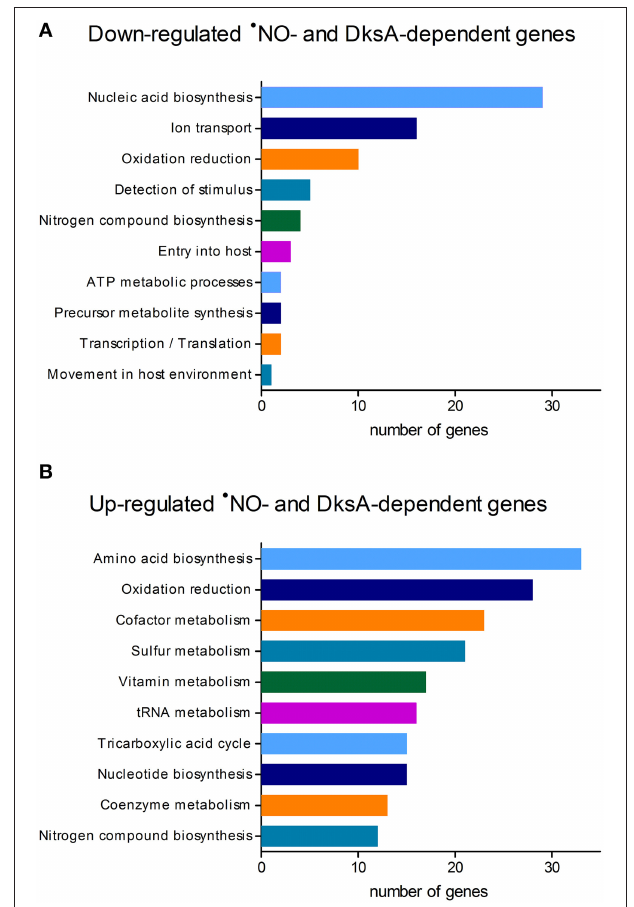
FIGURE 1 | Functional annotation of • NO- and DksA-dependent genes in Salmonella . Genome-wide expression analysis of wild-type and 1 dksA S . enterica serovar Typhimurium strain 14028s treated ± 5mM dNO, for 30 min at 37 ◦ C with continuous shaking, identified 427 genes ( ∼ 12% of all